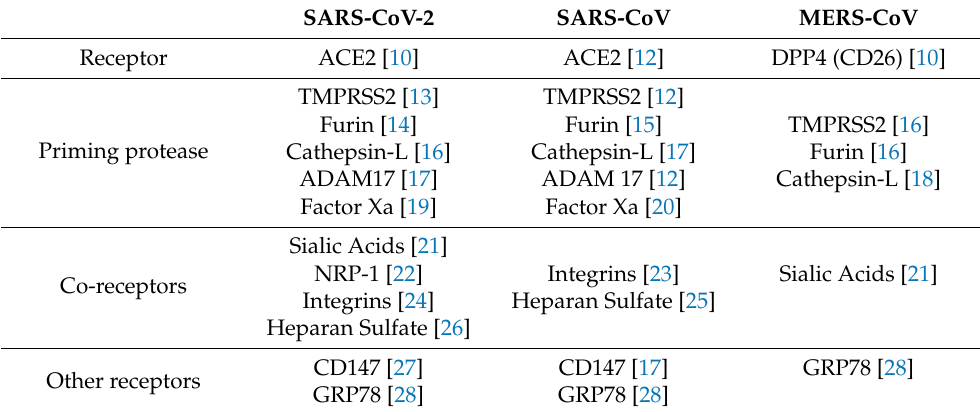
Table 1. Receptors, co-receptors and proteases involved in the infection of the three recent coron- avirus outbreaks. SARS-CoV-2 SARS-CoV MERS-CoV